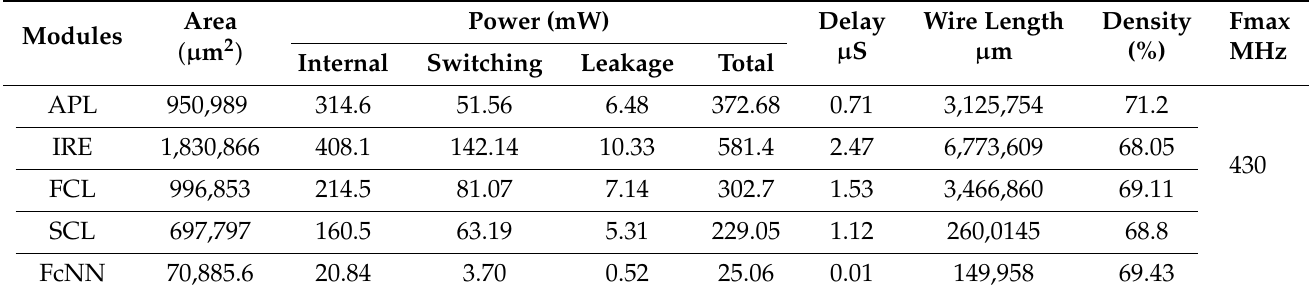
Table 5. Layout extracted parameters of the HARP Architecture in